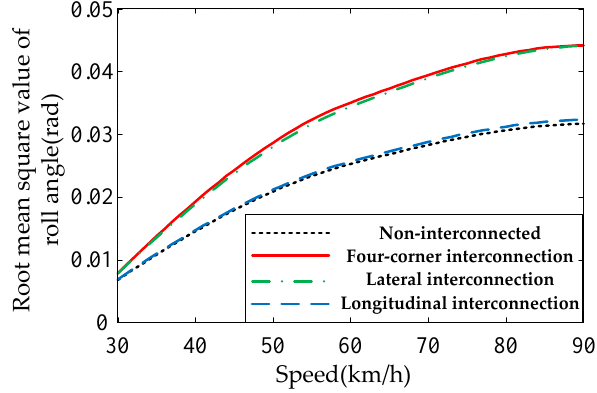
Figure 10. RMS value of roll angle under the steering condition.